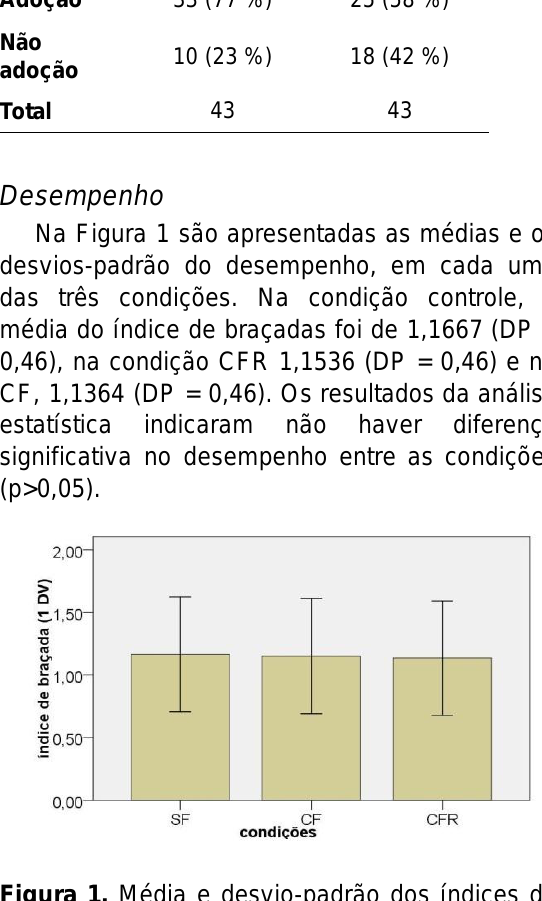
Figura 1. Média e desvio-padrão dos índices de braçadas nas condições de instrução sem foco de atenção (SF), com foco de atenção (CF) e instrução com foco de atenção e redundância (CFR), de todos os sujeitos da amostra. Para verificar se a semelhança entre os grupos no desempenho se deu em razão da não adoção do foco, analisou-se o desempenho corretamente o foco atencional solicitado. A Figura mostra o desempenho somente daqueles participantes que confirmaram ter adotado o foco solicitado em todas as condições (n=15).